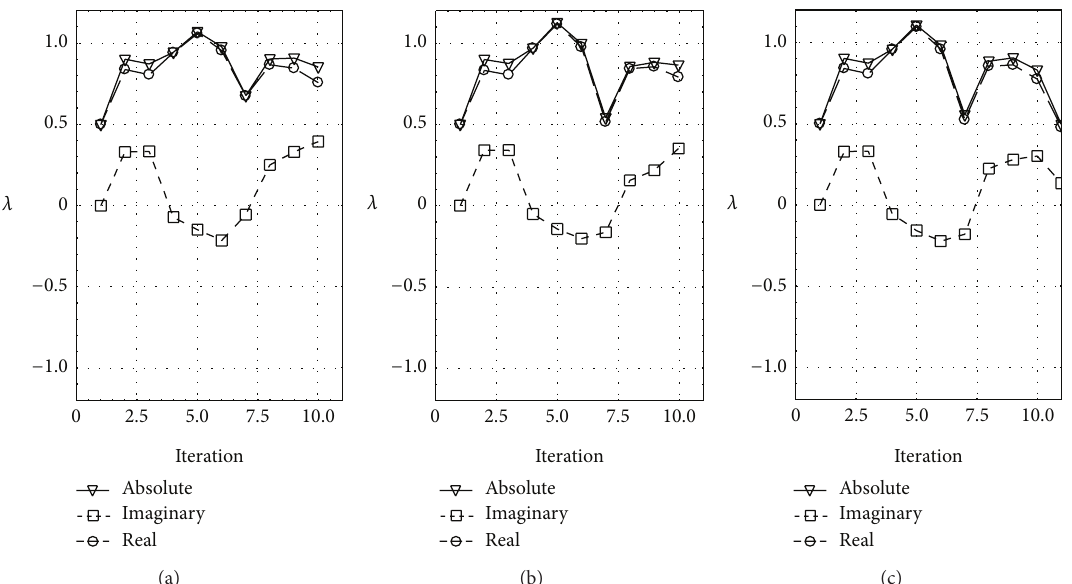
Figure 19: Variation of the complex relaxation parameter throughout the iterative process: (a) MFS-FEM; (b) MFS-CM; (c) MFS-MLPG. convergence cannot be reached at two sets of frequencies, associated with specific dynamic behaviours of the